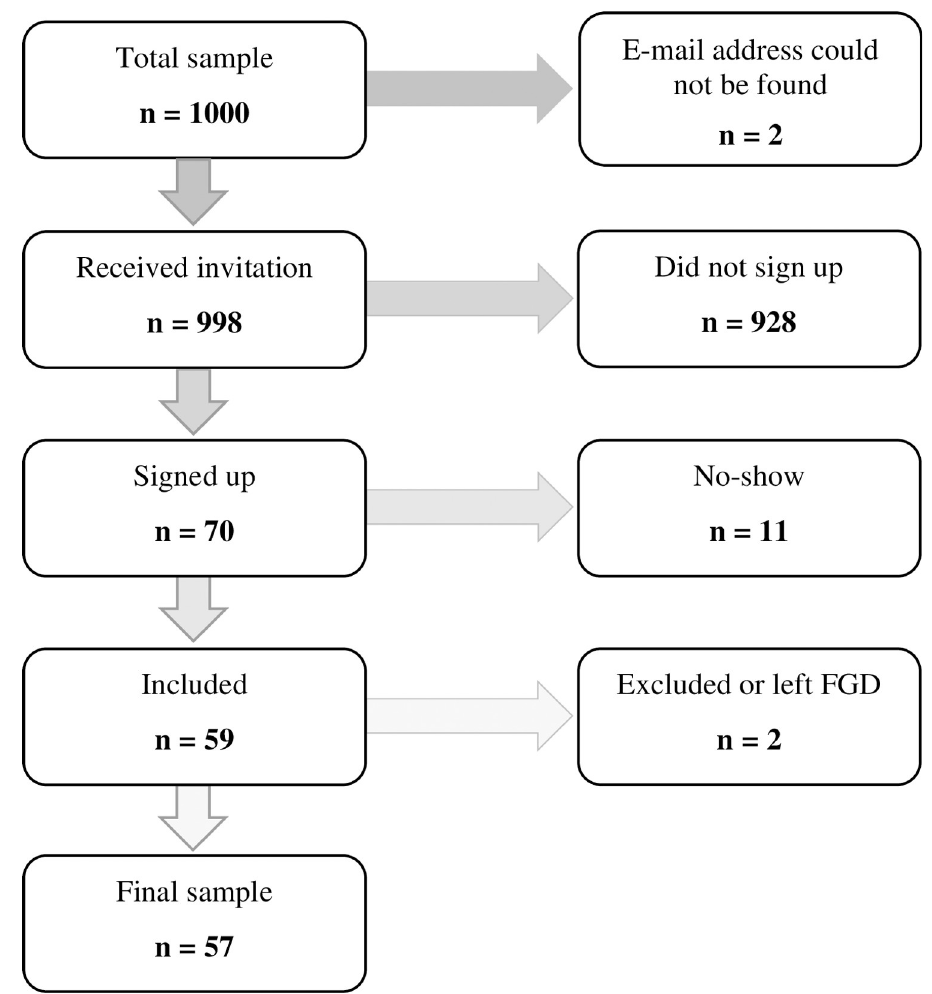
Fig 1. Recruitment process flowchart. FGD, focus group